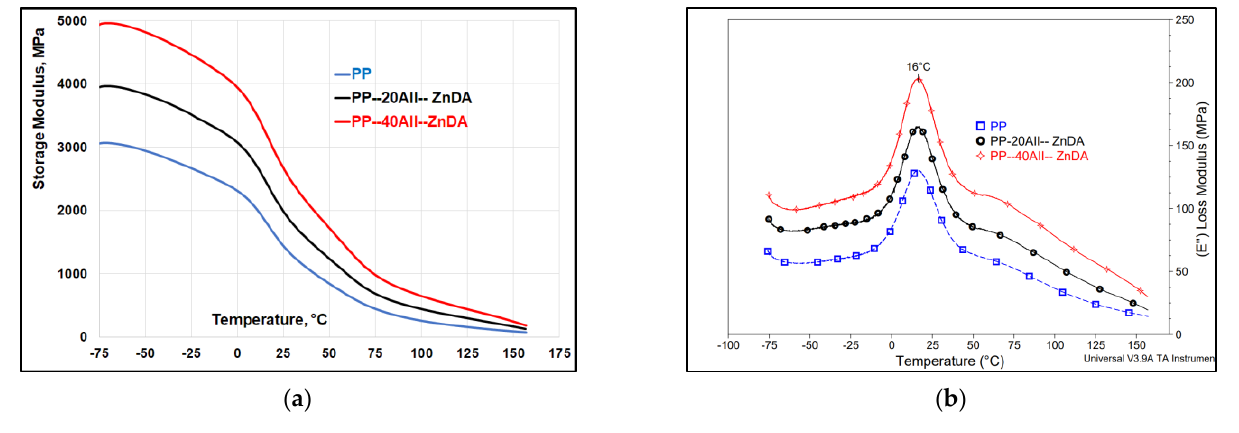
Figure 13. ( a , b ) DMA evaluations of PP vs. PP–AII–ZnDA composites obtained by REx. Evolution of ( a ) storage modulus (E’) and of ( b ) loss modulus (E“). Table 5. Comparative values of storage modulus (E’) at different temperatures for the neat PP and PP–AII composites modified by REx.